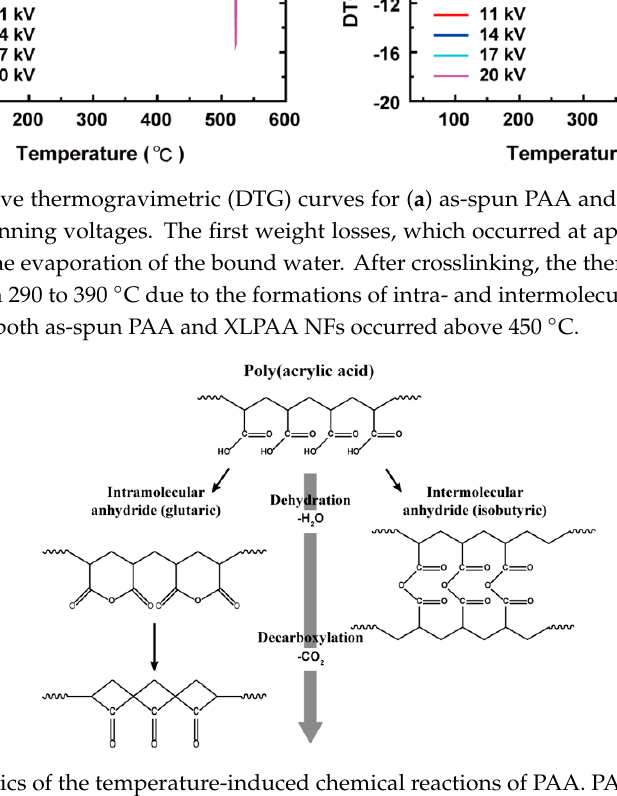
Figure 3. Schematics of the temperature-induced chemical reactions of PAA. PAA is crosslinked via intra-/interchain dehydrations and decarboxylation which accompany the losses of water and CO 2 molecules, respectively.